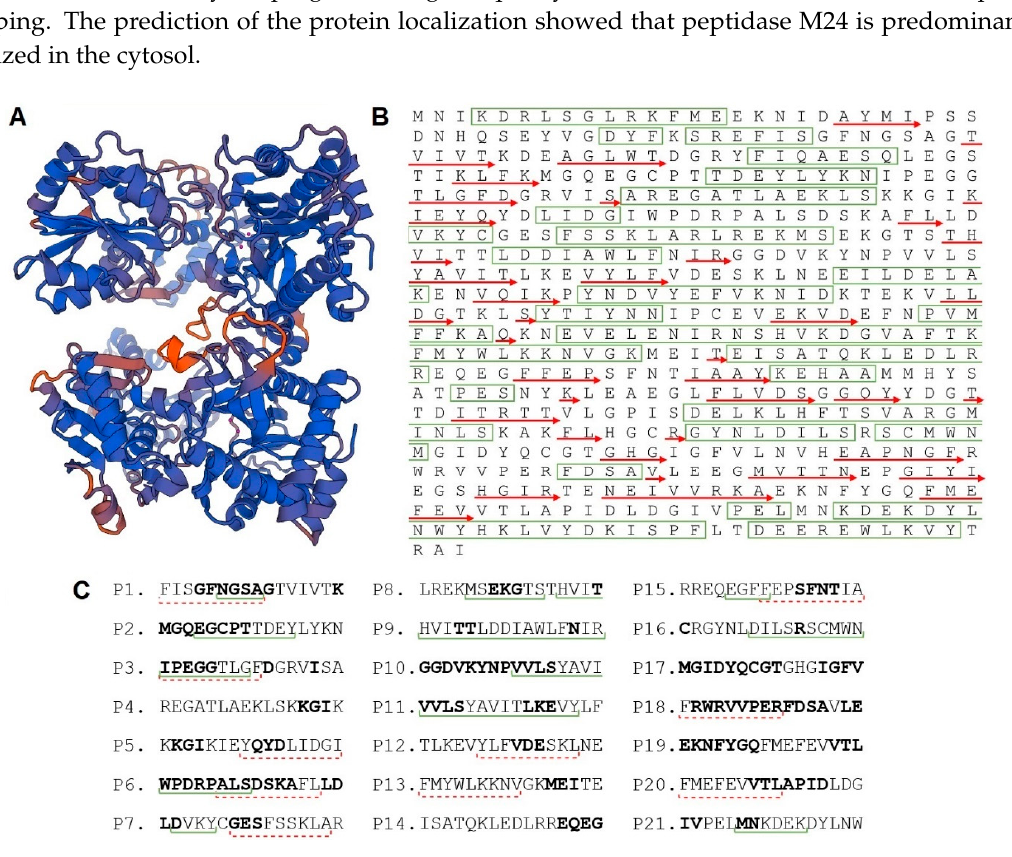
Figure 2. Results of the bioinformatics analysis of peptidase M24. ( A ) Structural model of peptidase M24 created by SWISS-MODEL. ( B ) Localization of α -helices (green rectangles), β -structures (red arrows) in the protein sequence. ( C ) Peptides selected for PEPSCAN synthesis with underlined B-cell (green, continuous line) and T-cell (red, dotted line) in silico predicted epitopes. Bold amino acids correspond with unstructured protein sequences.